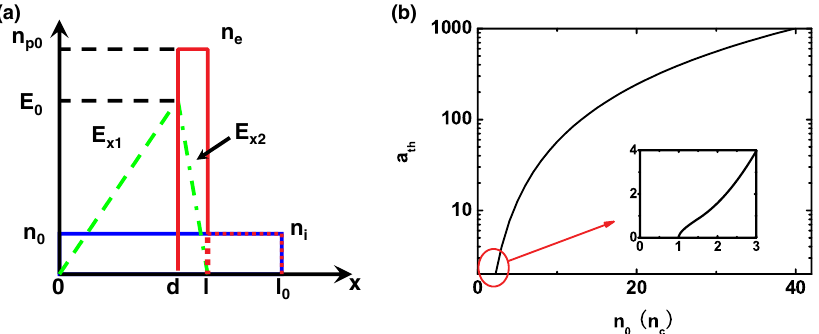
FIG. 1. (a) Sketch of ion density n i (blue solid line), electron density n e (red solid line), electrostatic field E x 1 (green dashed line), and E x 2 (green dash dotted line) in the hole-boring stage. (b) Threshold values of the laser amplitude a th obtained from Eqs. (13) and